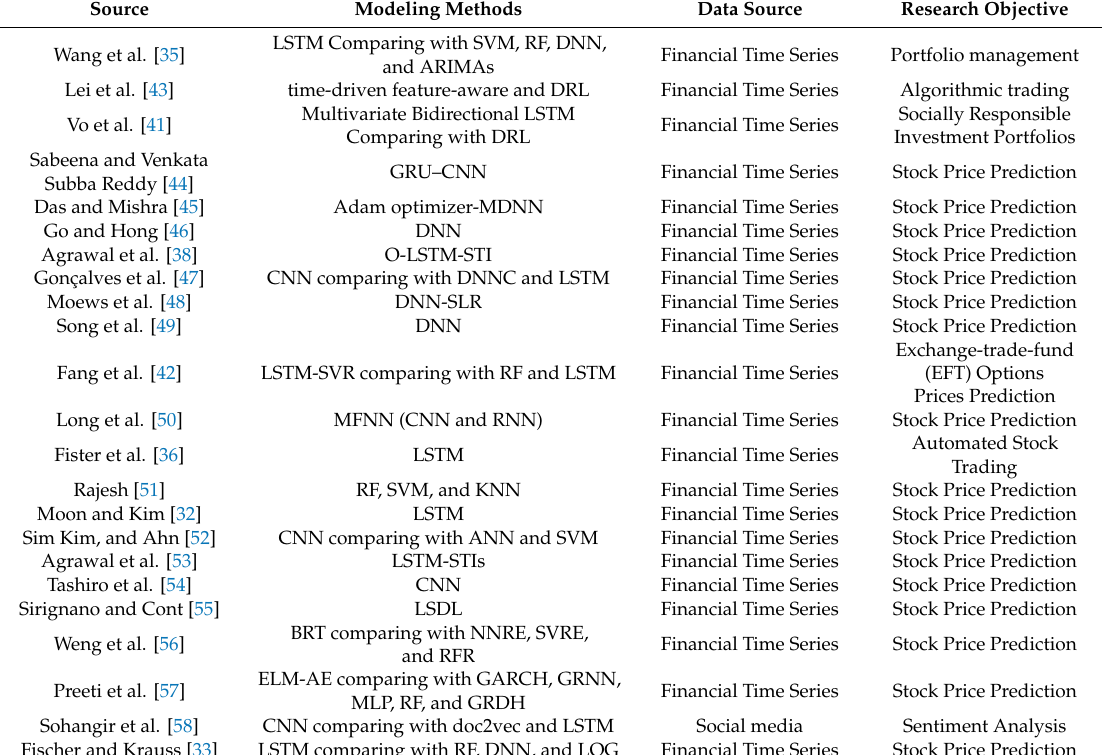
Table 2. Notable machine learning and deep learning methods in stock